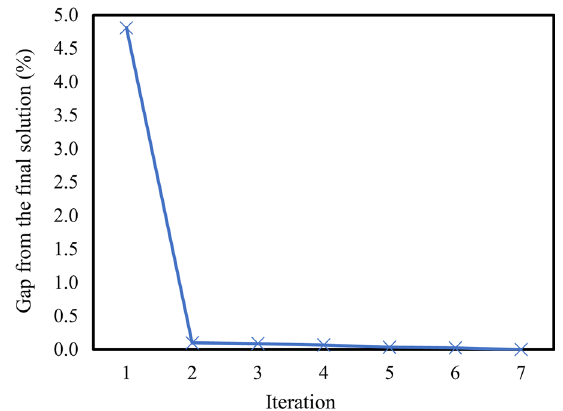
Fig. 3 Convergence of the solution algorithm